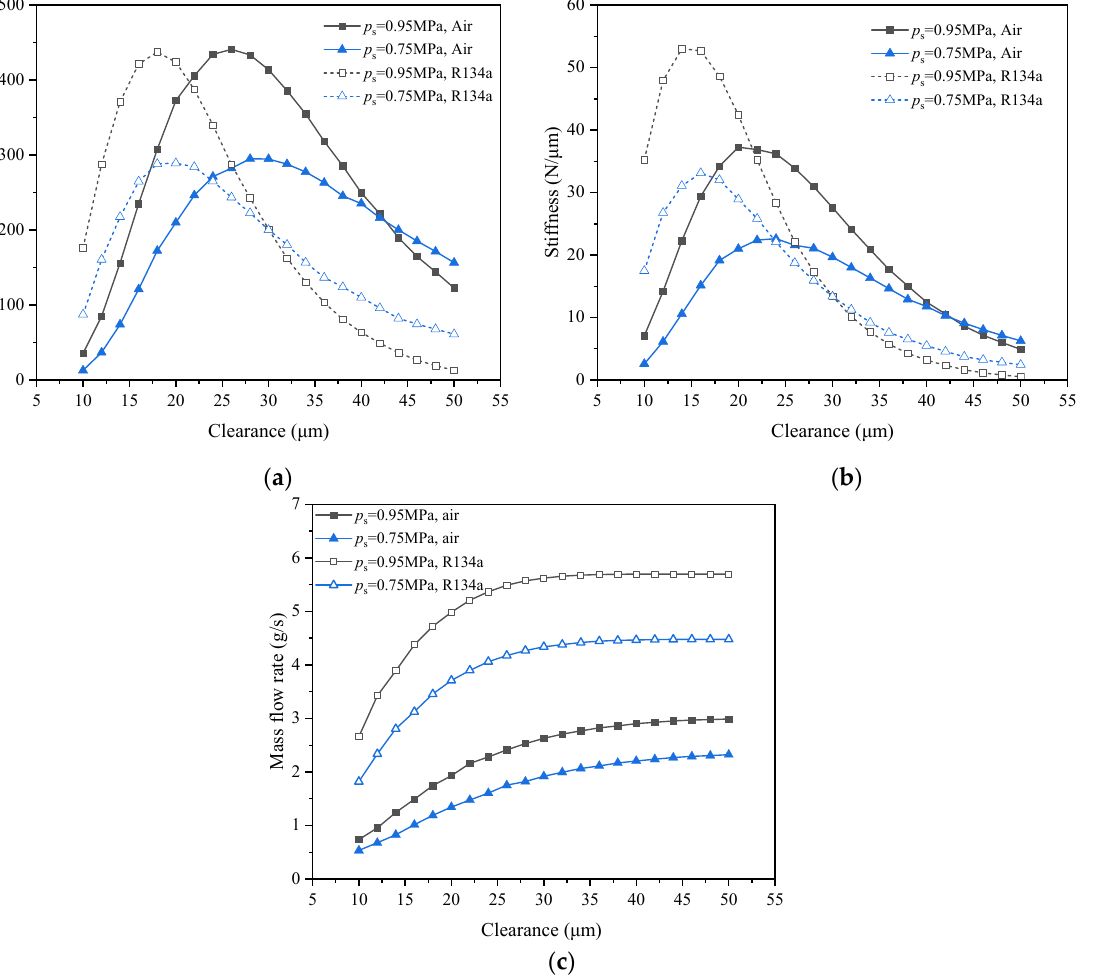
Figure 7. Effect of average clearance under different supply pressures ( ε = 0.5, d = 0.3 mm) ( a ) on load capacity ( b ) on stiffness ( c ) on mass flow rate. load capacity ( b ) on stiffness ( c ) on mass flow